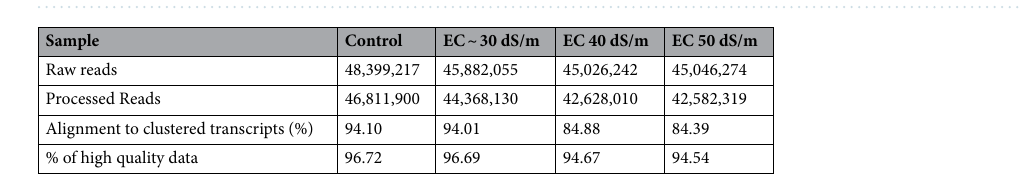
Figure 2. Transcripts length distribution for Urochondra sequences.